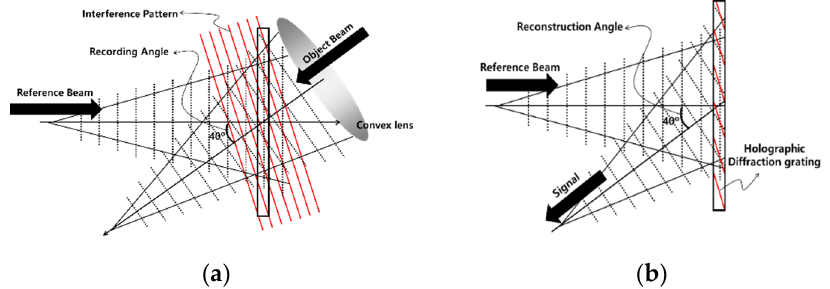
Figure 4. Holographic optical element (HOE) recording and reconstruction: ( a ) recording; ( b ) reconstruction.